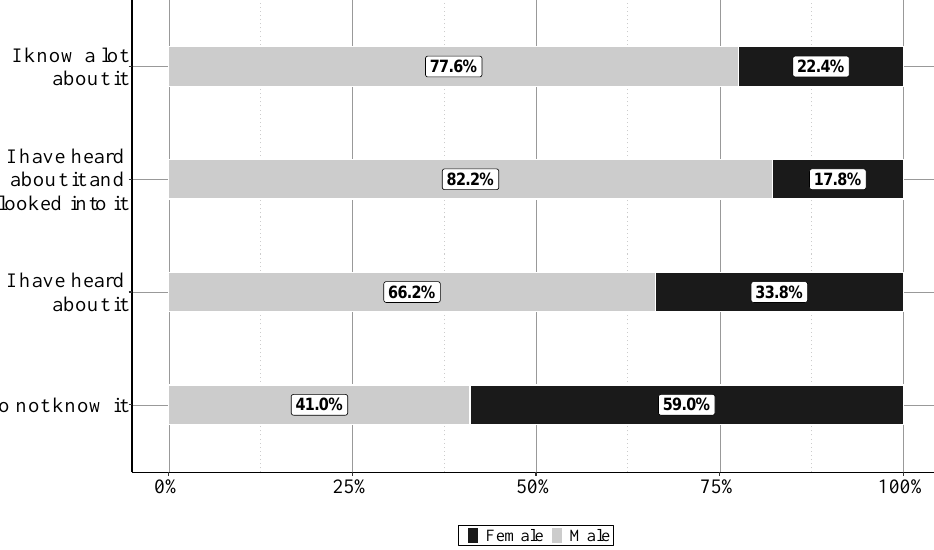
Figure 6. Respondents’ familiarity with Hyperloop by